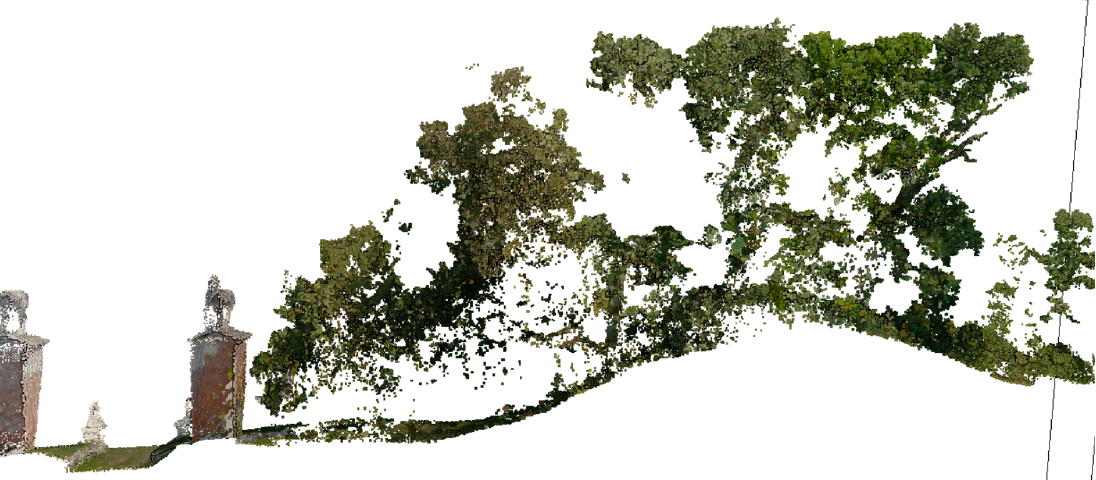
Figure 5. Vertical profile of the 3D point cloud illustrating the vertical profile of thick vegetation and the terrain.